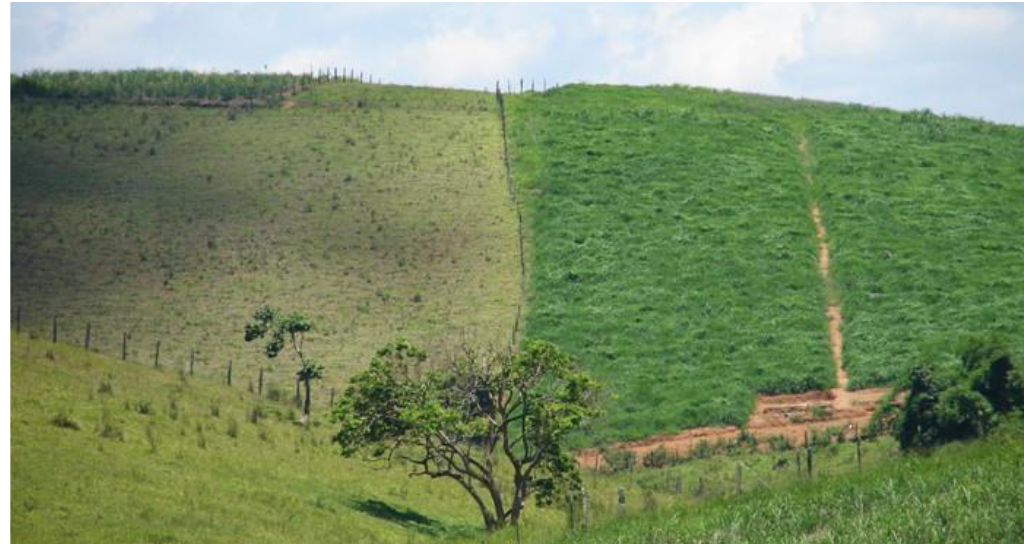
Figure 15. Urochloa brizantha in a vegetative phase, after being sown just before the end of tomato harvest; the pasture on the left had been not submitted to crop – livestock integration [11].